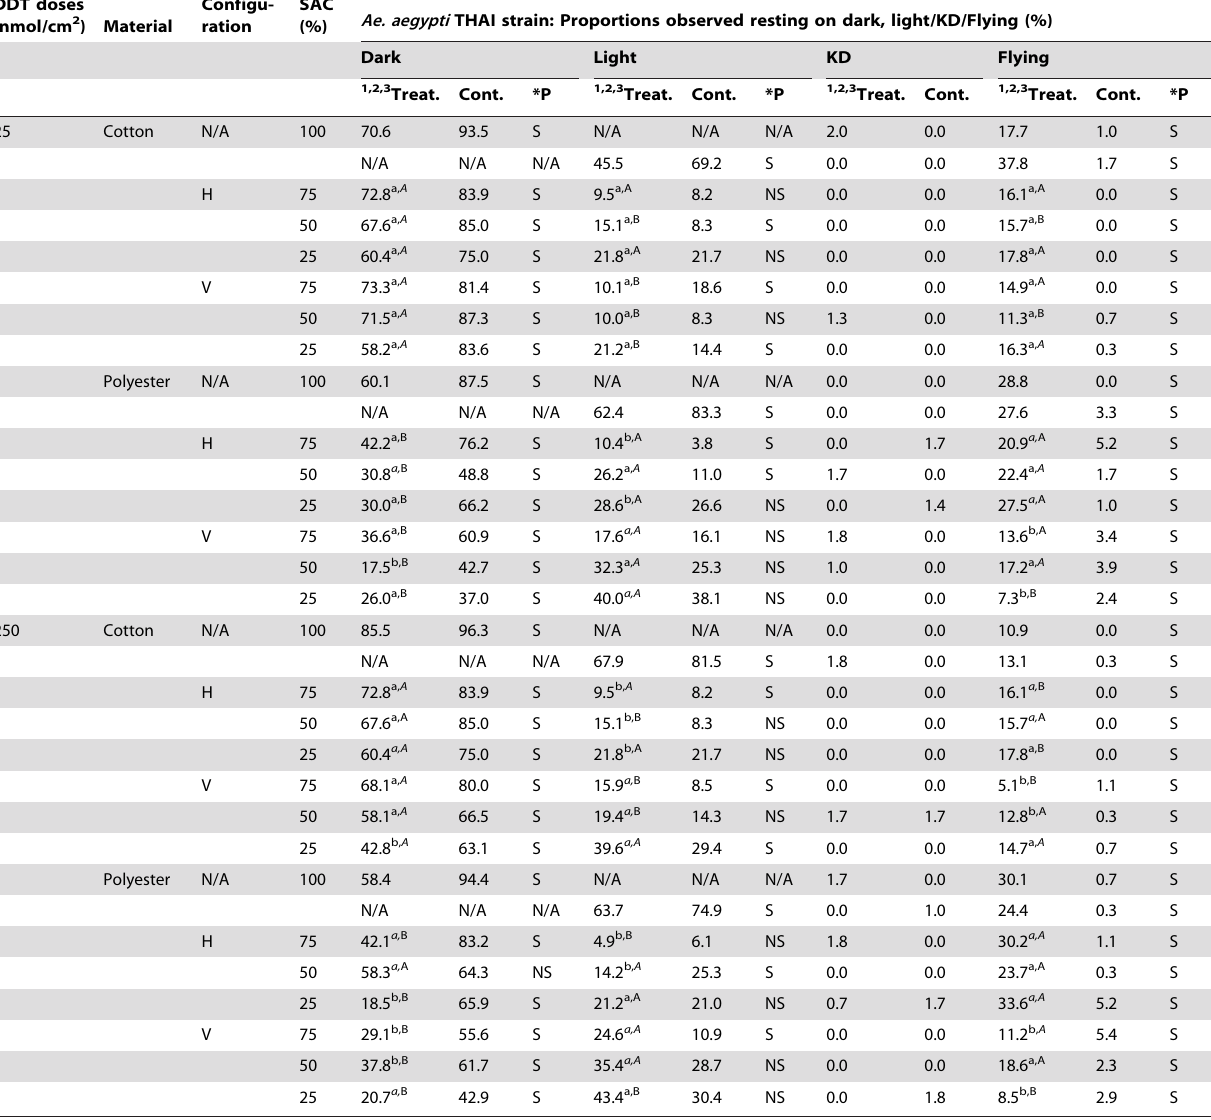
DDT doses (nmol/cm 2 )